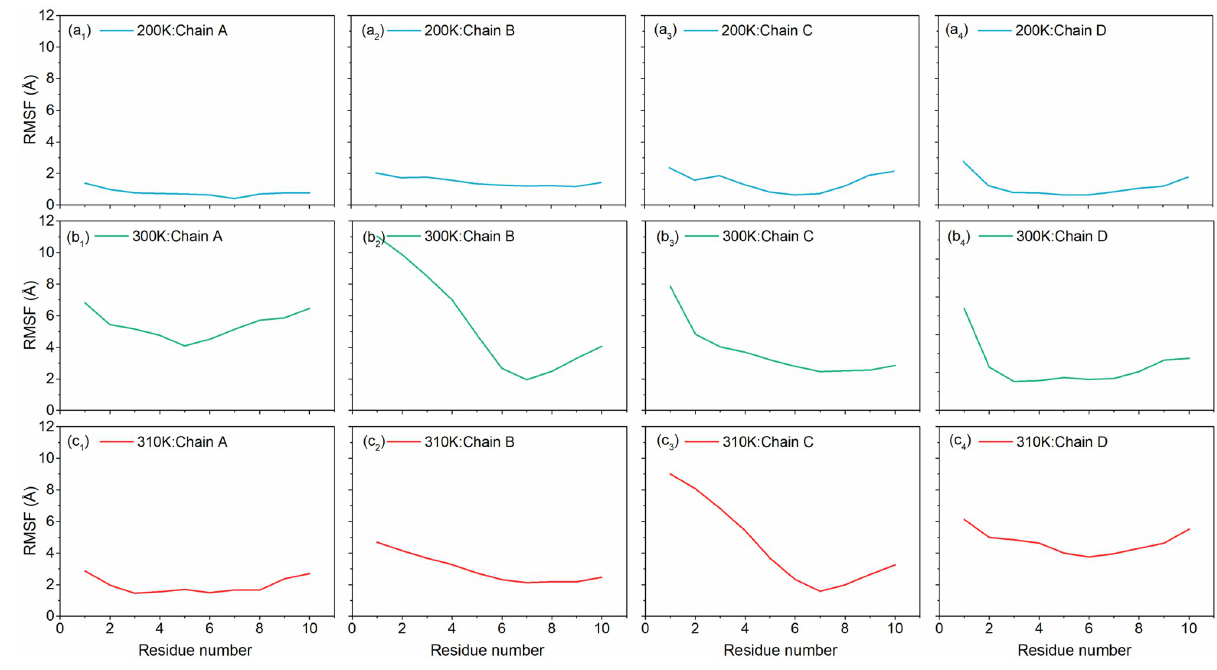
Fig 3. RMSF plots of the MD simulated DNA Junctions at (a) 200K, (b) 300K, and (c) 310K respectively.